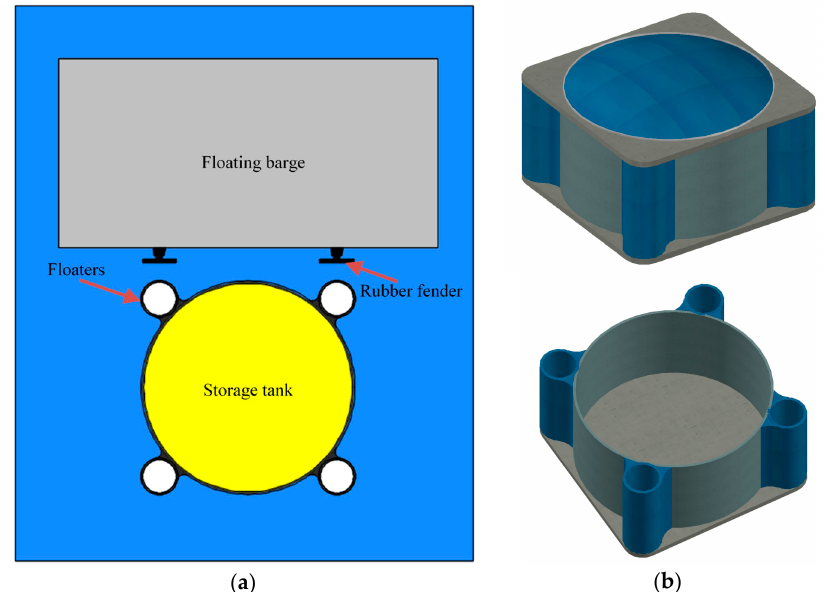
Figure 36. Single hull tank with four hollow cylindrical floaters: ( a ) plan view and ( b ) isometric view.